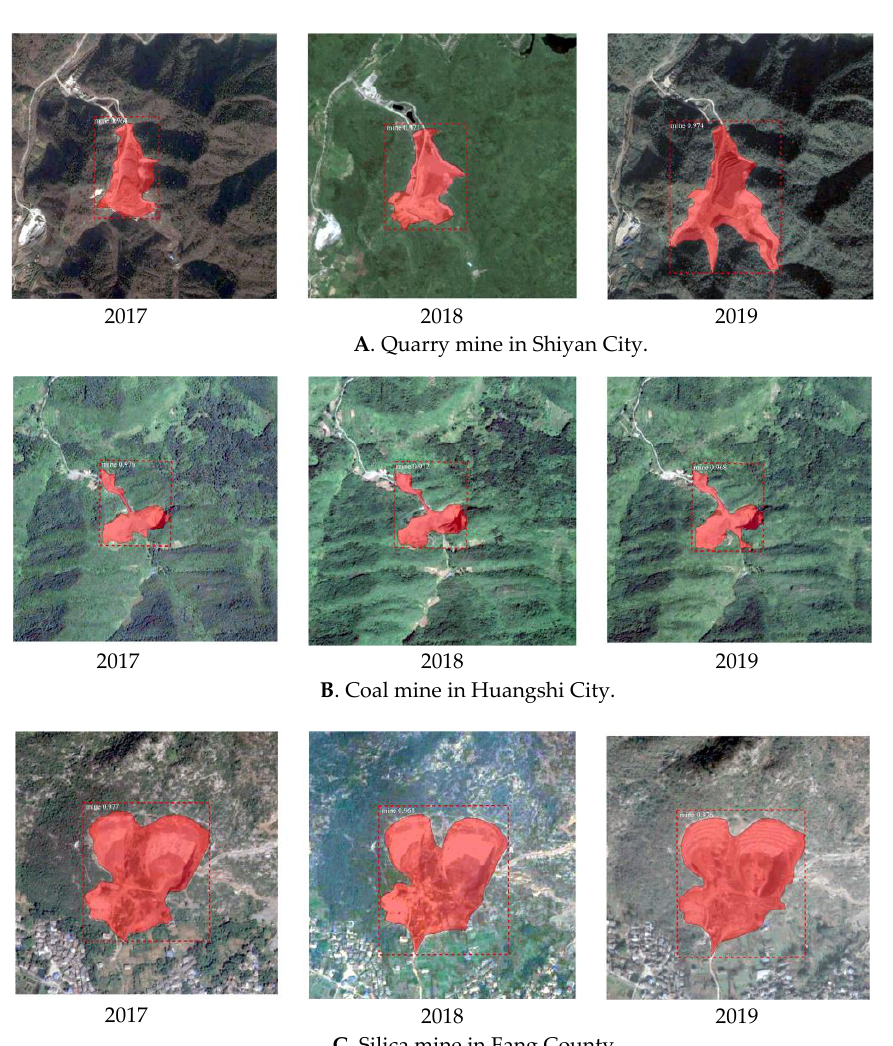
Figure 11. MissingAlarm and FalseAlarm based on objects.